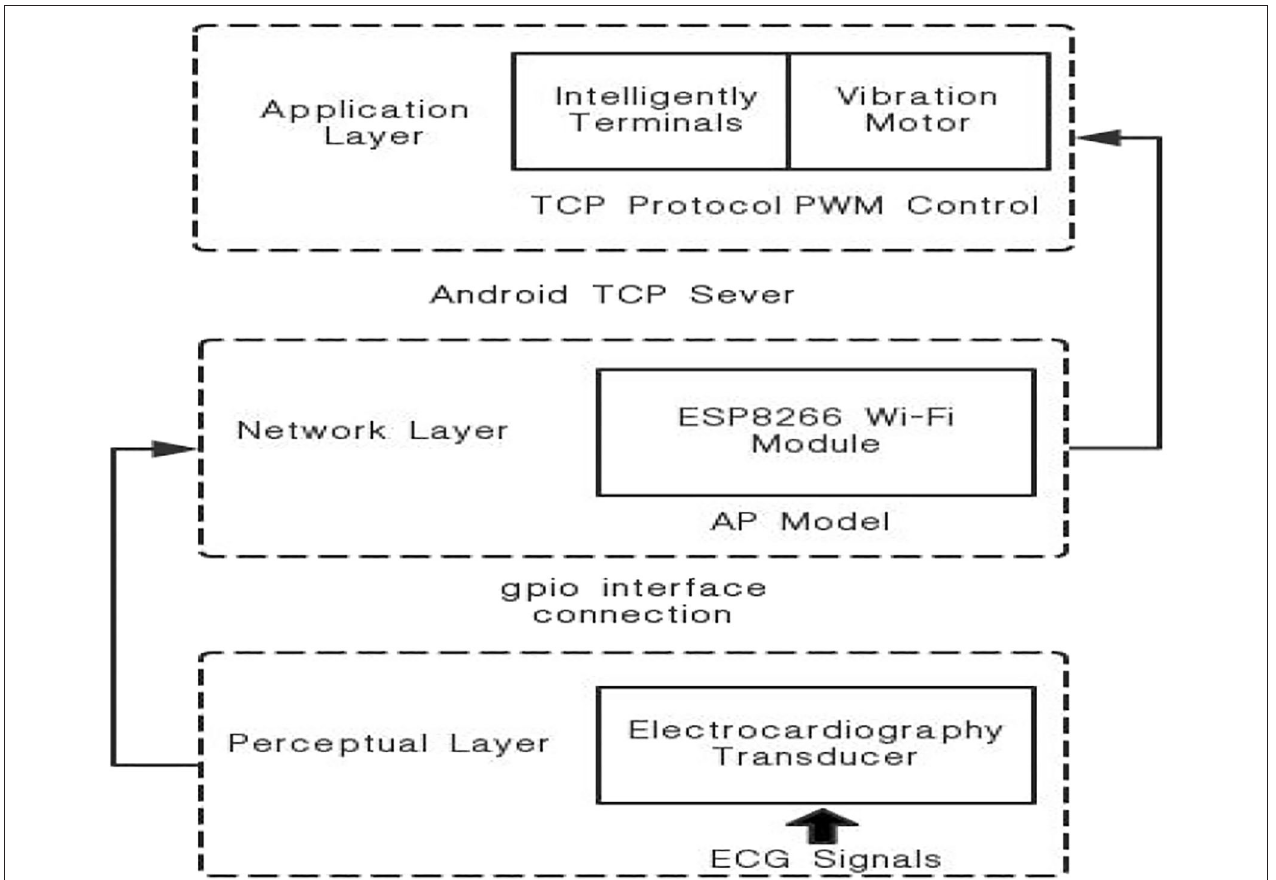
FIGURE 1 | OSA patient monitoring system